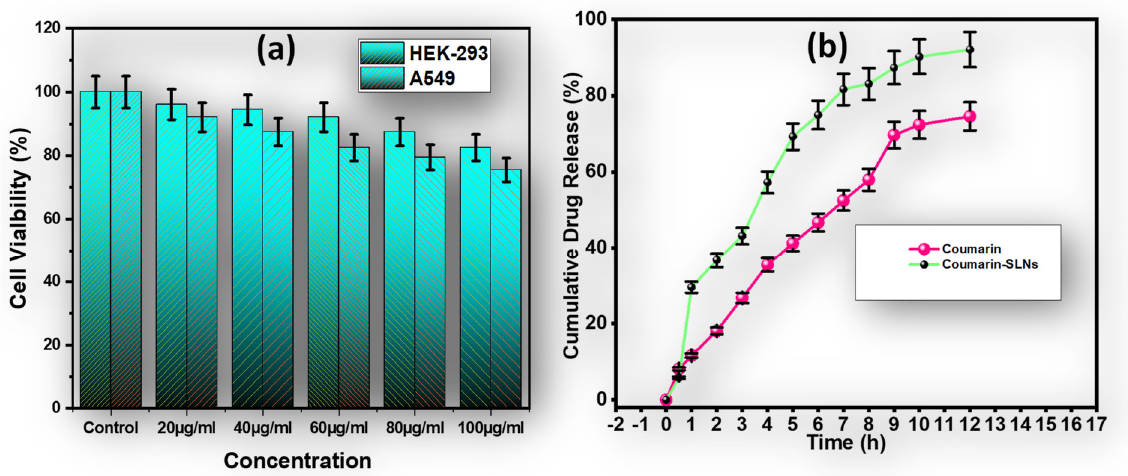
Figure 3. ( a ) The % cell viability assay of coumarin-loaded SLN dispersions in different concentrations; ( b ) the comparative in vitro drug release study of coumarin powder and coumarin-SLNs.